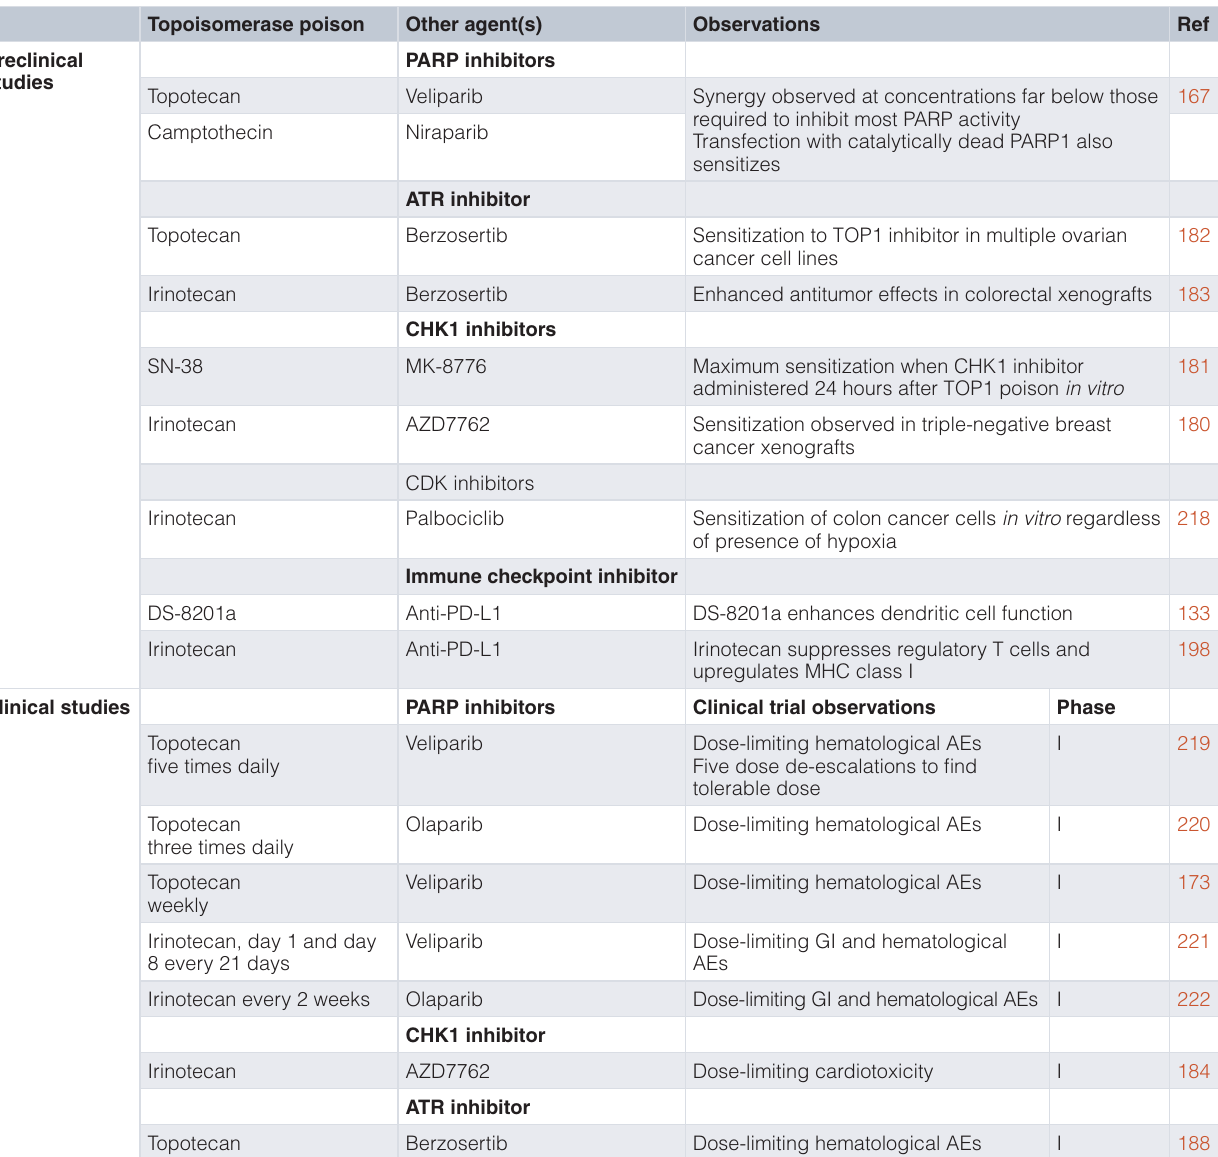
Table 4. Recently described combinations of TOP1 or TOP2 poisons with other agents. Topoisomerase